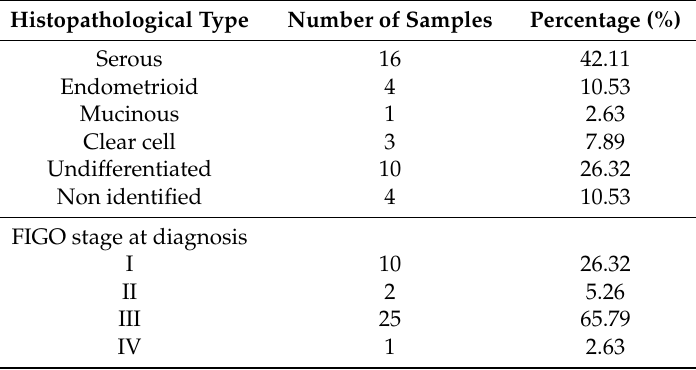
FIGO: International Federation of Gynaecology and